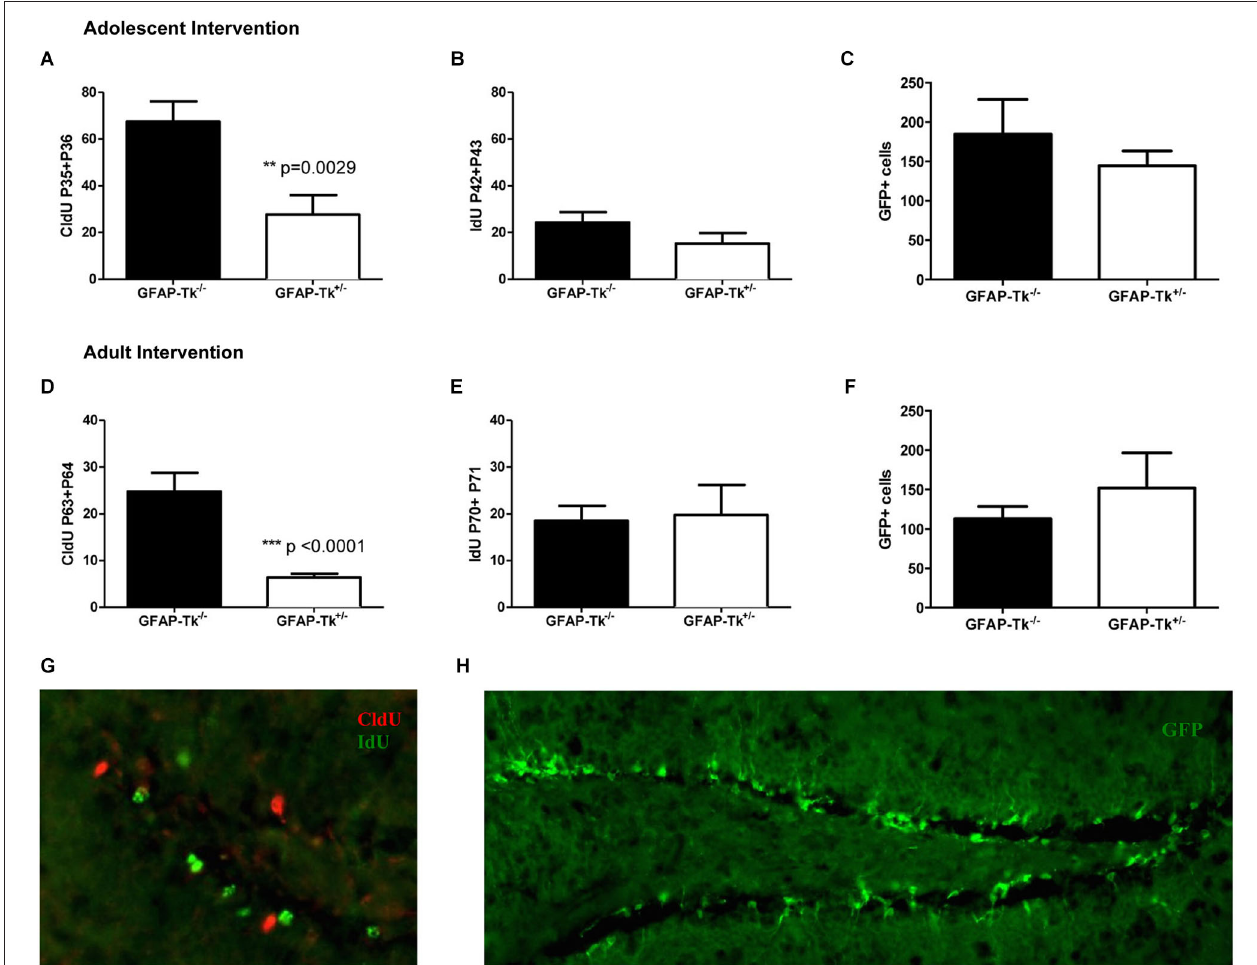
VGCV during adulthood, P56-P63, show a reduction in proliferative marker CldU administered at the end of treatment and assessed at P130 (Tk − / − n = 12, Tk + / − n = 16). (E) There is no change in proliferative marker IdU administered 7 days after termination of treatment and assessed in adulthood (Tk − / − n = 4, Tk + / − n = 4) or (F) in the cumulative production of Nestin progeny labeled by GFP indicating a reversible reduction in neurogenesis between P56 and P70 (Tk − / − n = 9, Tk + / − n = 7). (G) Representative image of CldU labeled cells (green) and IdU labeled cells (red) in the SGZ. (H) Representative image of GFP labeling of nestin cell lineage. Bars represent mean ±